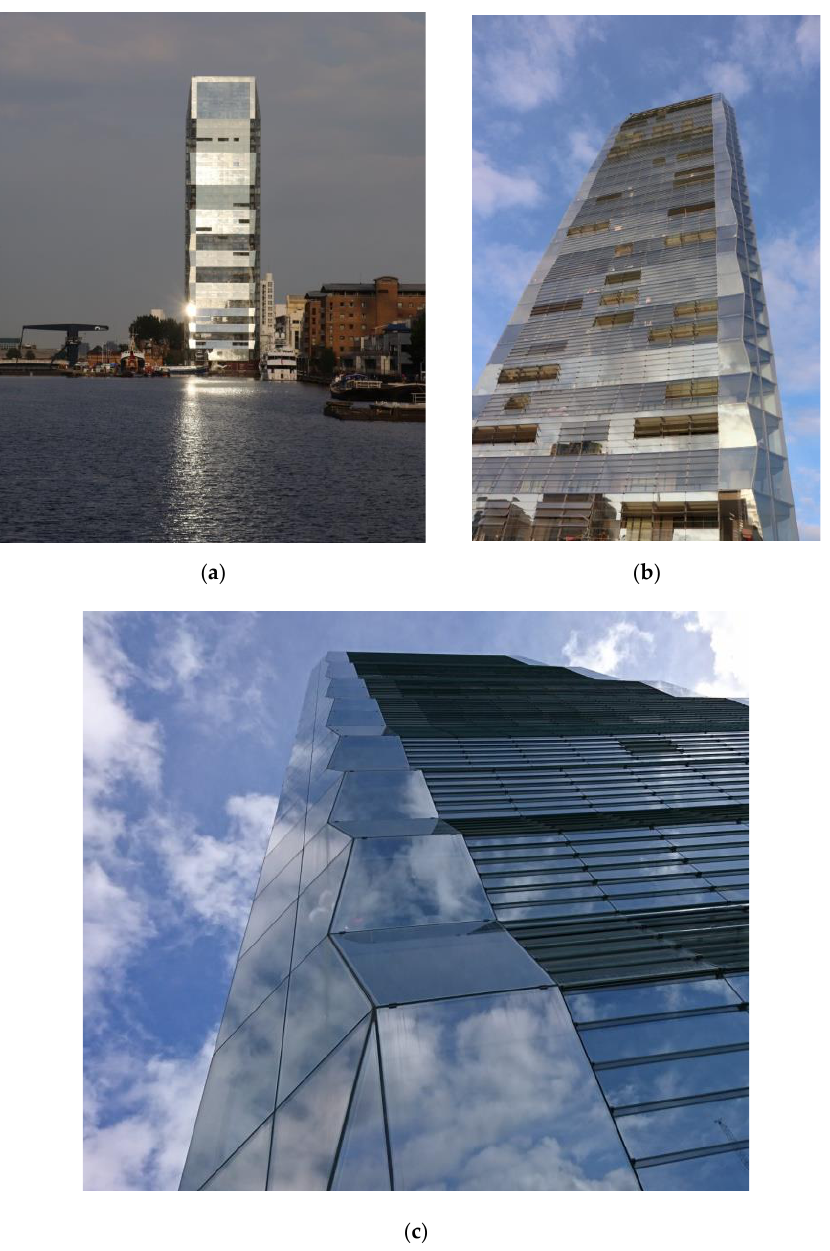
Figure 10. Sunshine as a colouring factor, One Dollar Bay building: ( a ) Western elevation with glass reflectivity amplified by the sunset light; ( b ) close-up detail and transparent glass properties induced by daylight conditions (2019); ( c ) reflectivity visually dissolves the building in the sky (2019). The next step on the evolution of glass towers for living is using projecting ribbons or glass curtain walls and balustrades to define the buildings’ homogenous forms. Simi- larly to previous examples, sunlight is a colouring factor. In the case of Baltimore Wharf by SOM hovering doughnuts of balconies form an organic twisting tower. The depth of those terraces delivers shadow on curtain wall facades. A combination of void between